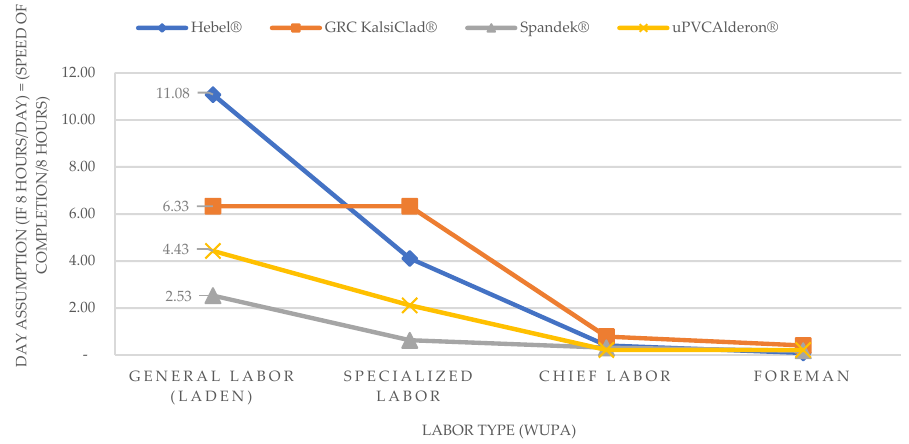
Figure 6. Speed of construction completion by type of labor using WUPA method.